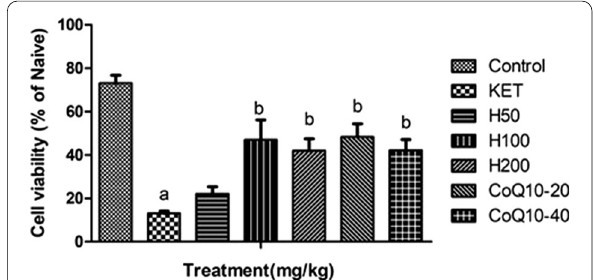
Fig. 17 Effect of hesperidin and Coenzyme Q10 on complex IV enzyme activity in the prefrontal cortex region of the brain. Data were analyzed by one-way ANOVA followed by Tukey’s post hoc analysis. All values were expressed as Mean SEM. a p < 0.05 as compared ± to naive, b p < 0.05 as compared to ketamine. KET, Ketamine; H, Hesperidin; CoQ10, Coenzyme Q10